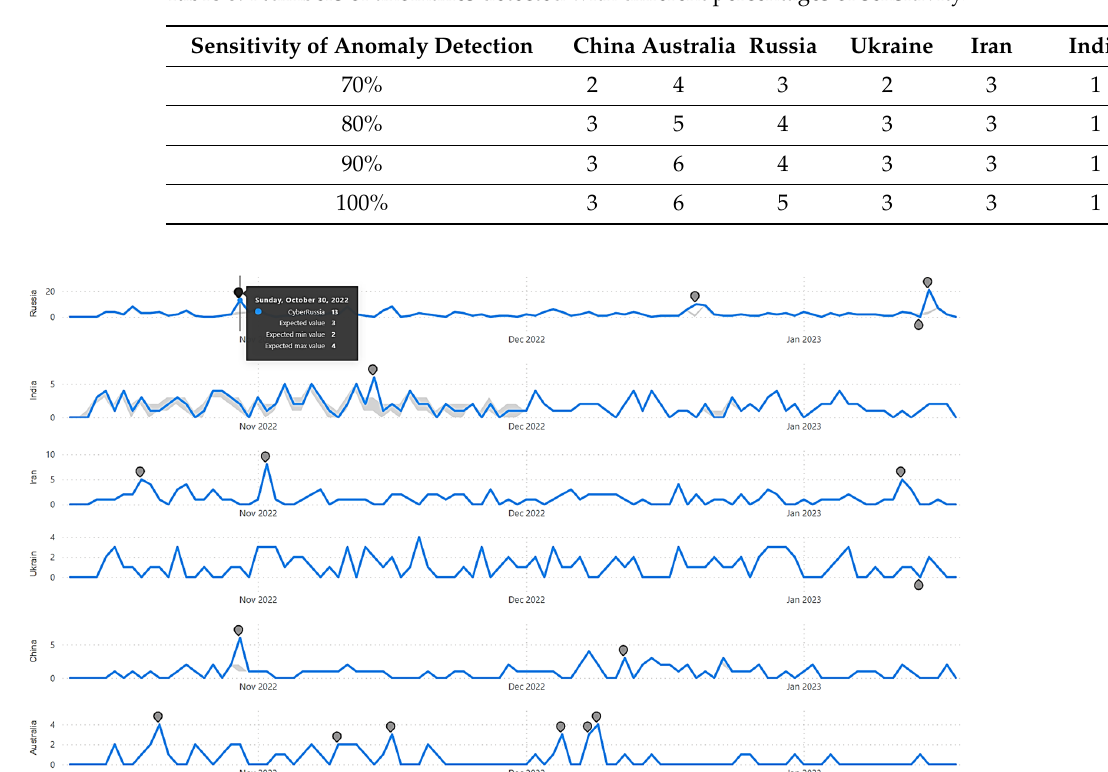
Figure 4. Social media-based cyber threat dashboard executed on a Samsung Galaxy Note 10 Lite Mobile (Android Device).